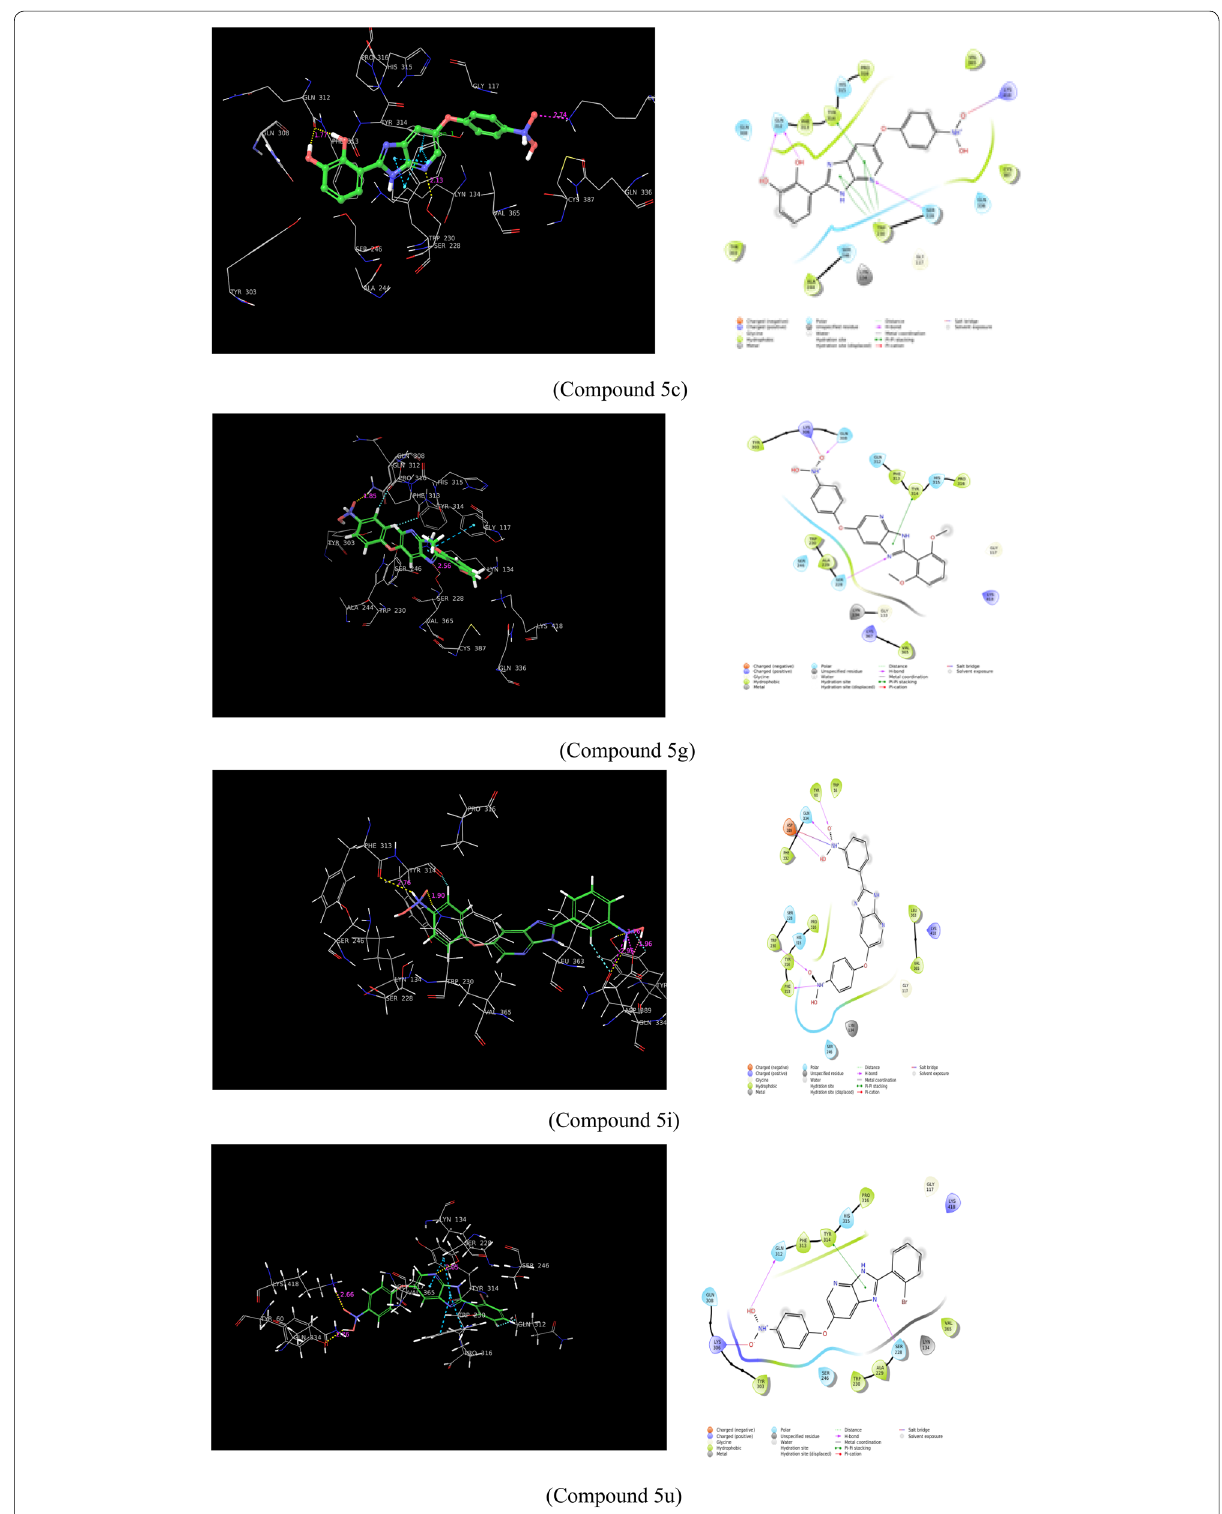
Fig. 1 Binding model of compounds 5c , 5g , 5i and 5u with DprE1 target cavity. It represents hydrogen bonds, hydrophobic interactions and pi-pi